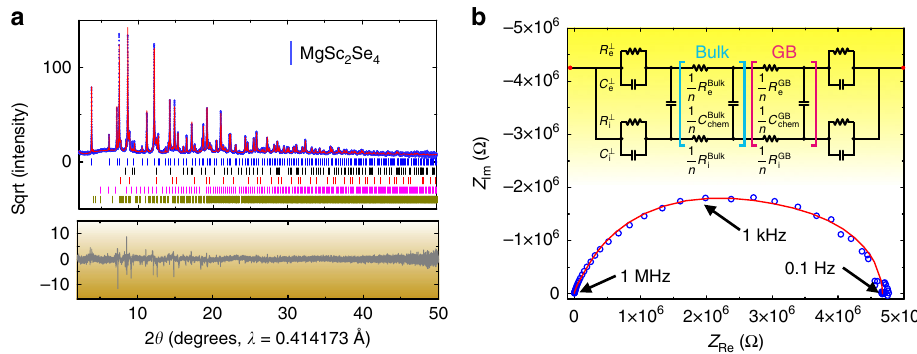
Fig. 2 X-ray diffractions and electrochemical impedance characterizations of MgSc 2 Se 4 . a Rietveld re fi nement of the synchrotron XRD pattern for MgSc 2 Se 4 . The square root of the intensity is plotted on the y -axis. The observed and calculated curves are shown in blue and red in the top panel, and the difference curve is shown in dark gray in the bottom panel. Re fl ections corresponding to MgSc 2 Se 4 (blue), Mg (black), MgSe (red), Sc 2 O 3 (magenta), and Sc 2 Se 3 (dark yellow) are shown with tick marks of the respective colors. b Impedance spectrum of the Ta/MgSc 2 Se 4 /Ta cell, and the circuit utilized in the fi tting of the impedance data (Supplementary Fig. 10). The observation is shown in blue circles and the fi t is displayed in red. The equivalent circuit utilizes two Jamnik – Maier elements 41 , which are tentatively attributed to contributions from bulk and grain boundary, respectively. Supplementary Fig. 12 shows the impedance behavior at low Z